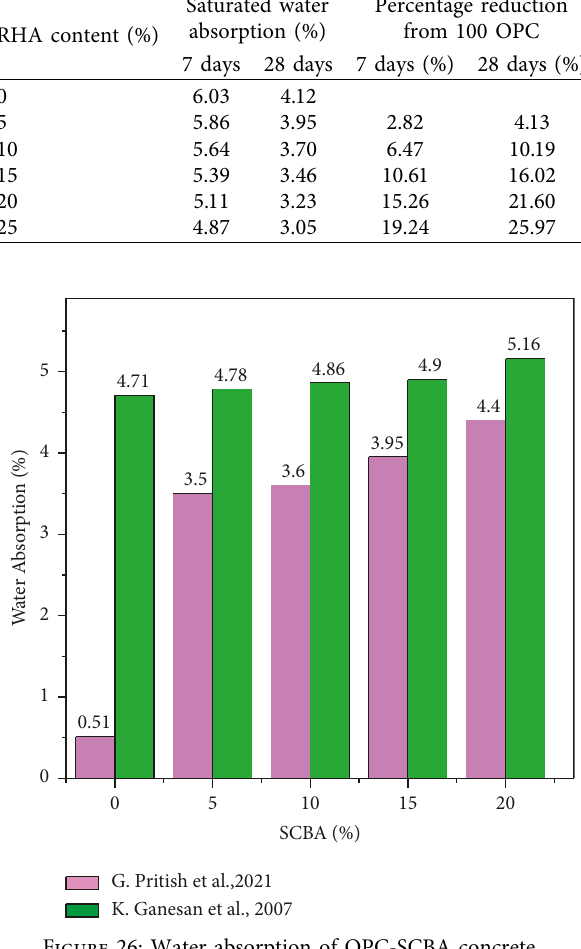
Figure 26: Water absorption of OPC-SCBA